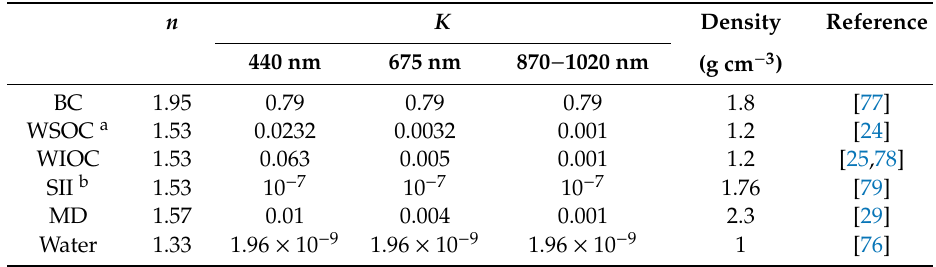
Table 2. Complex refractive indices and densities of selected components used to estimate the columnar mass concentration (mg m − 2